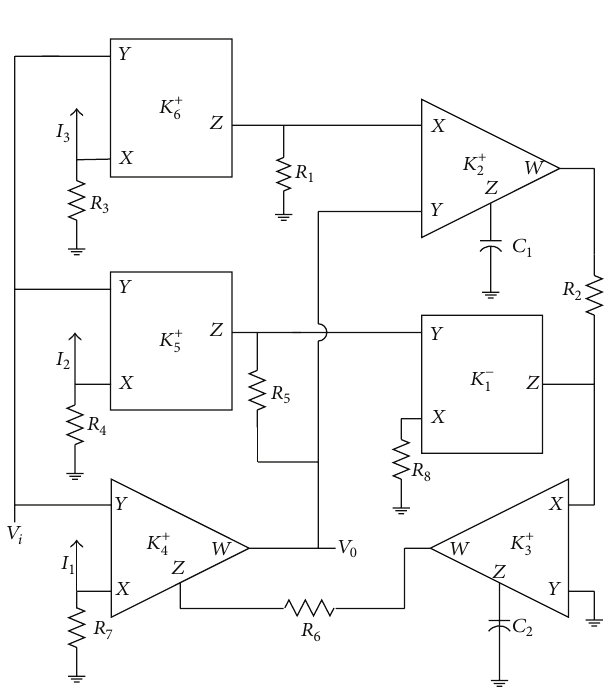
Figure 3: Proposed reconfigurable